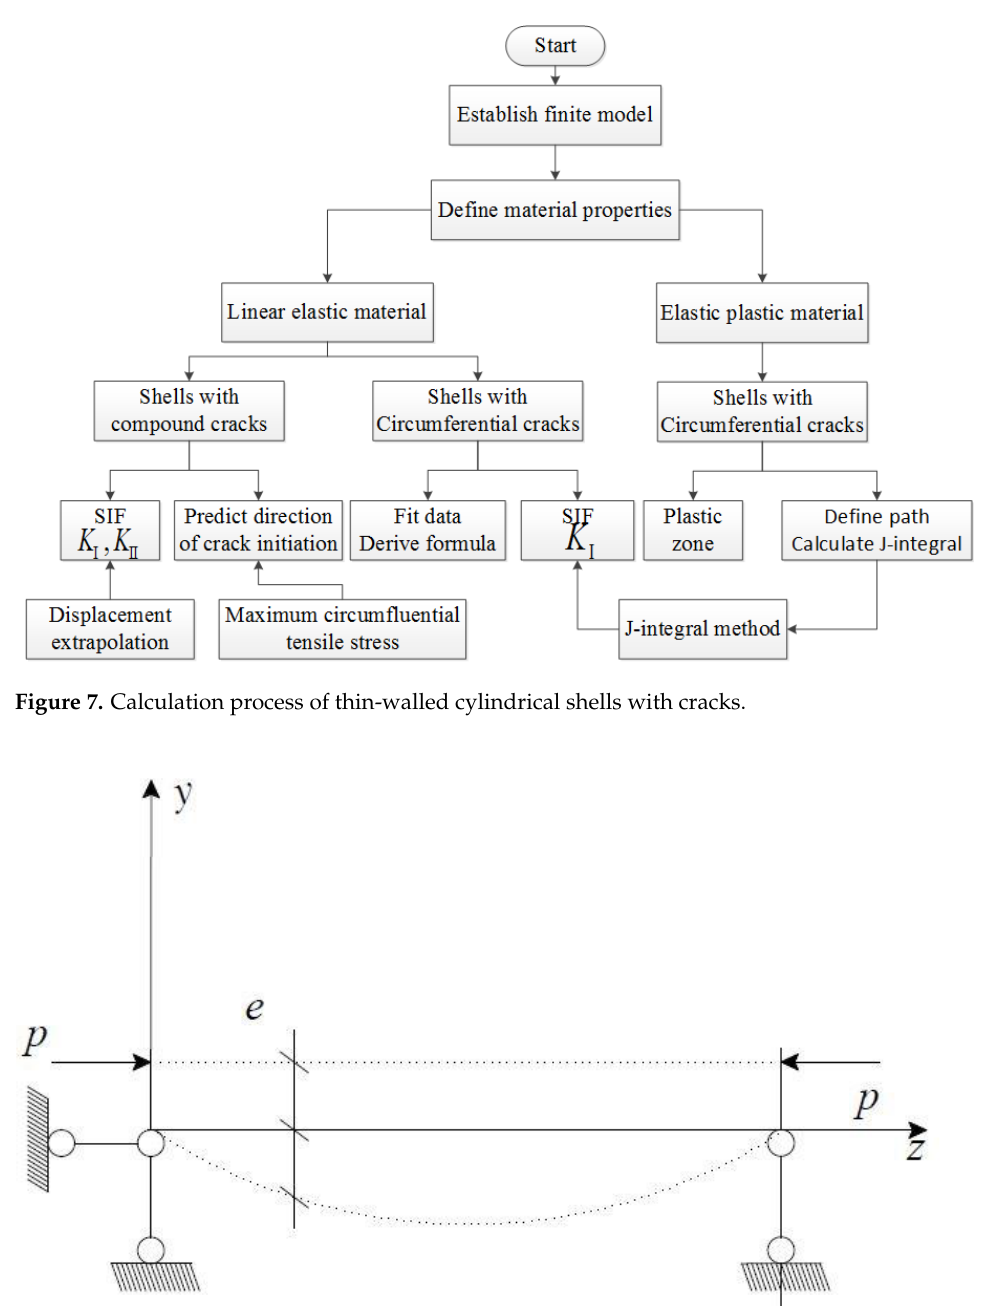
Figure 7. Calculation process of thin-walled cylindrical shells with cracks.